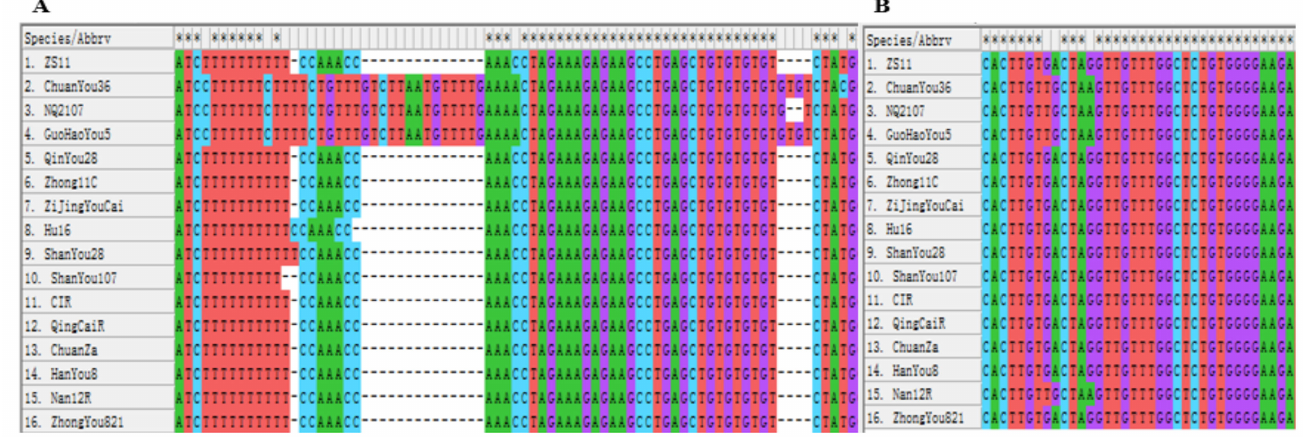
Figure 2. Sequence alignment of BnP5CR2 . ( A ) Alignment based on gene. ( B ) Alignment based on